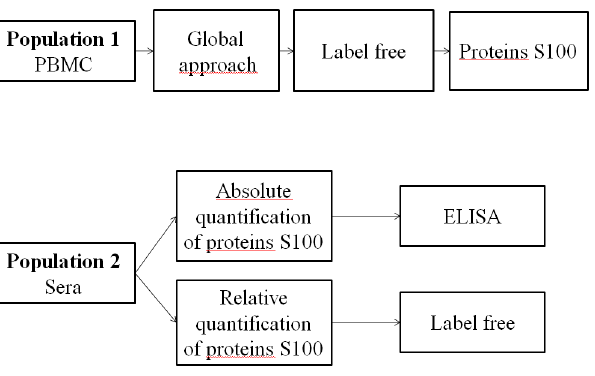
Fig. 1. Experimental workflow. In the first stage, a label free approach was used to determine candidate proteins that are differentially expressed in PBMCs between responder (R) and non-responder (NR) RA patients before initiation of etanercept in the population 1. This approach was used to quantify the relative abundance of S100 proteins. To independently confirm these results, label free approach by mass spectrometry and absolute quantification by ELISA were used to quantify S100 proteins in sera samples from R and NR RA patient before etanercept initiation in the population 2.